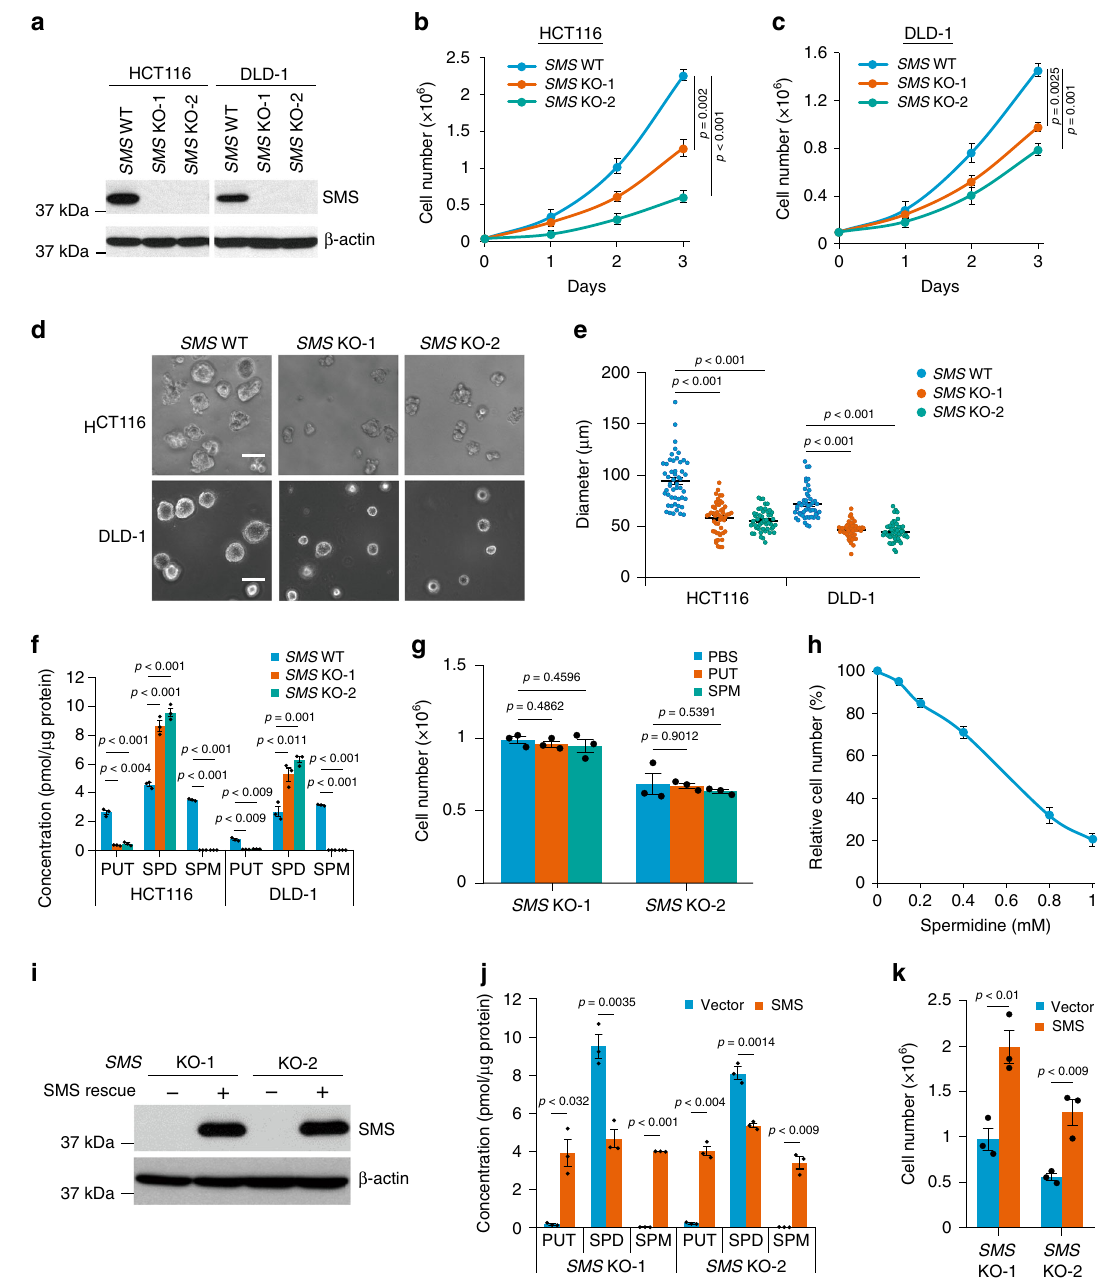
Fig. 2 SMS knockout inhibits CRC cell growth associated with spermidine accumulation. a Cells from two SMS knockout (KO) HCT116 or DLD-1 clones, and their control wild-type (WT) cells were analyzed by western blot for the indicated proteins. b , c SMS -WT or SMS -KO HCT116 ( b ) and DLD-1 ( c ) cells were assessed for cell growth over 3 days. d Representative phase-contrast images of SMS -WT or SMS -KO HCT116 and DLD-1 cells cultured in 3D Matrigel for 4 days. Scale bar, 100 µ m. e The diameter of 50 randomly chosen spheroids as shown in d were measured. f The levels of putrescine (PUT), spermidine (SPD), and spermine (SPM) in SMS -WT or SMS -KO HCT116 and DLD-1 cells were determined by LC-MS. g SMS -KO HCT116 cells were treated with 1 mM putrescine or 20 µ M spermine for 3 days, following by counting the number of viable cells. h HCT116 cells treated with the indicated concentrations of spermidine were assessed for cell growth over 3 days. Results are expressed as a percentage of cell number relative to values obtained in the control cells. i , j SMS -KO HCT116 cells with re-expression of SMS or vector control were analyzed by western blot ( i ) for the indicated proteins, or by LC-MS analysis ( j ) for the levels of PUT, SPD, and SPM. k SMS -KO HCT116 cells with re-expression of SMS or vector control were assessed for cell growth over 3 days. All graphic data are presented as mean values ±SEM ( n = 3 independent experiments in b , c , e – h , j and k ; n = 50 spheroids in d ). The indicated p -values were determined by two-tailed unpaired t test. Source data are provided as a Source Data fi